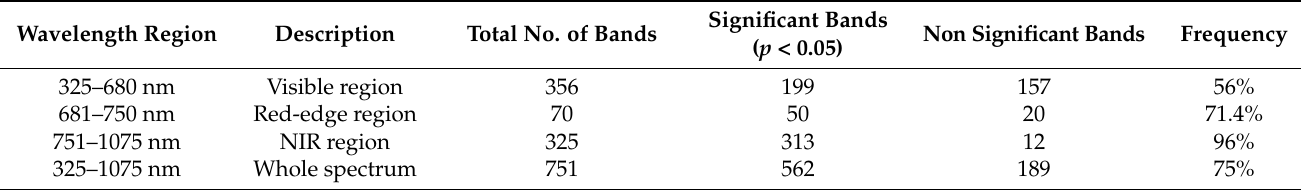
Table 4. Frequency of significant wavebands in different regions of electromagnetic spectrum based on ANOVA ( p < 0.05).